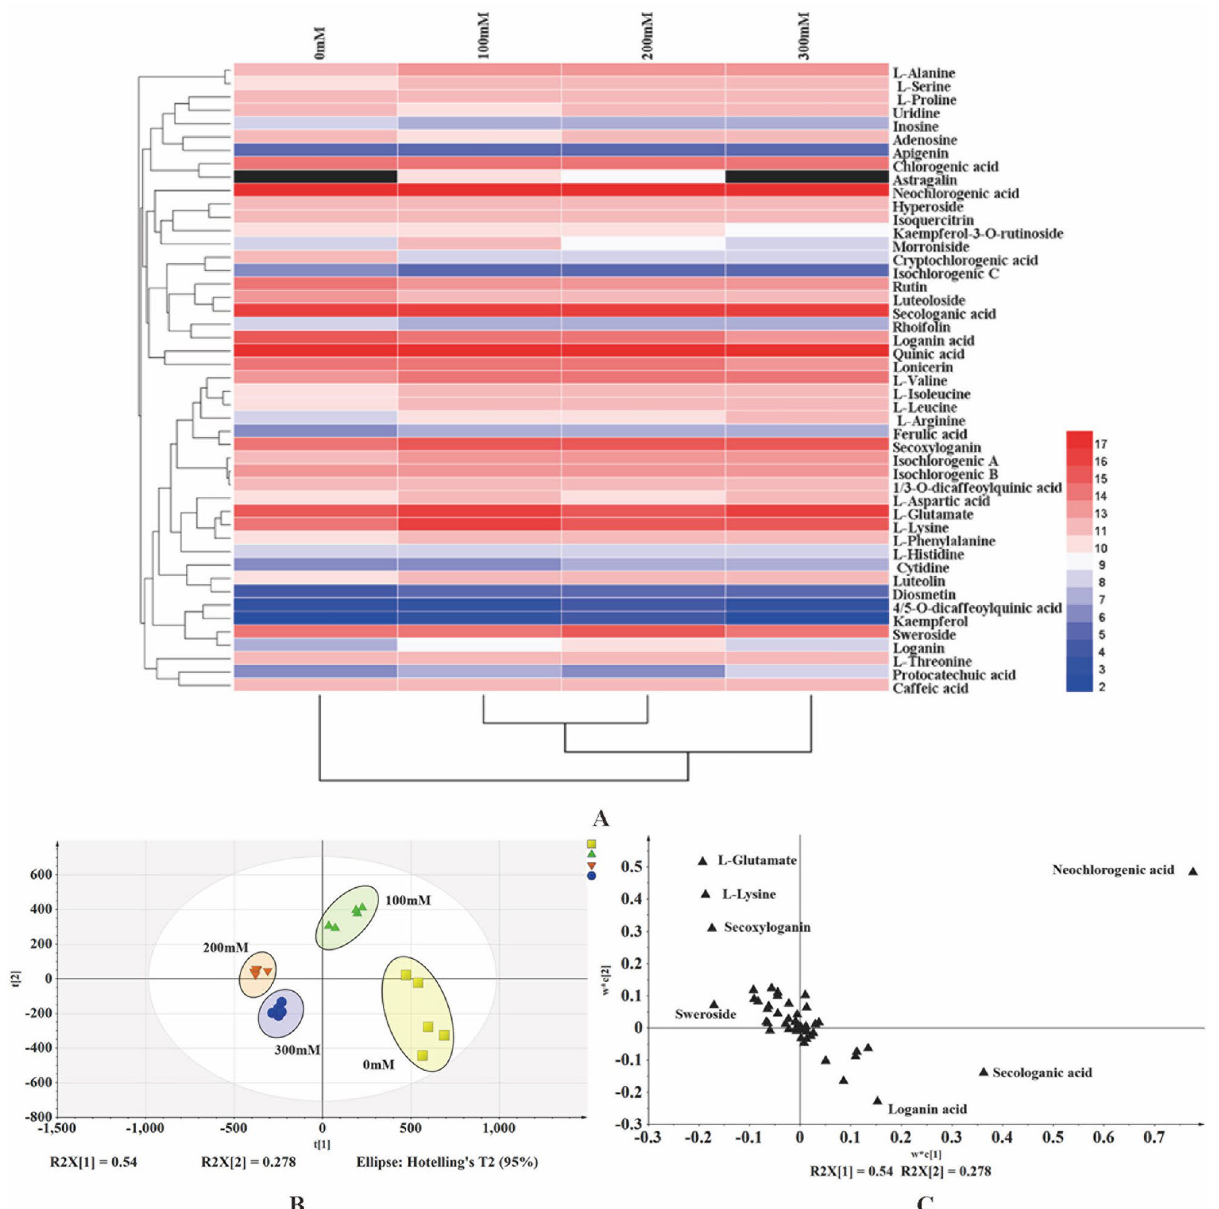
Figure 8. Multivariate Statistical Analysis of LJF under different salinity level. hierarchical clustering heat map ( A ), PLS-DA score plot ( B ), PLS-DA loading plot ( C ).